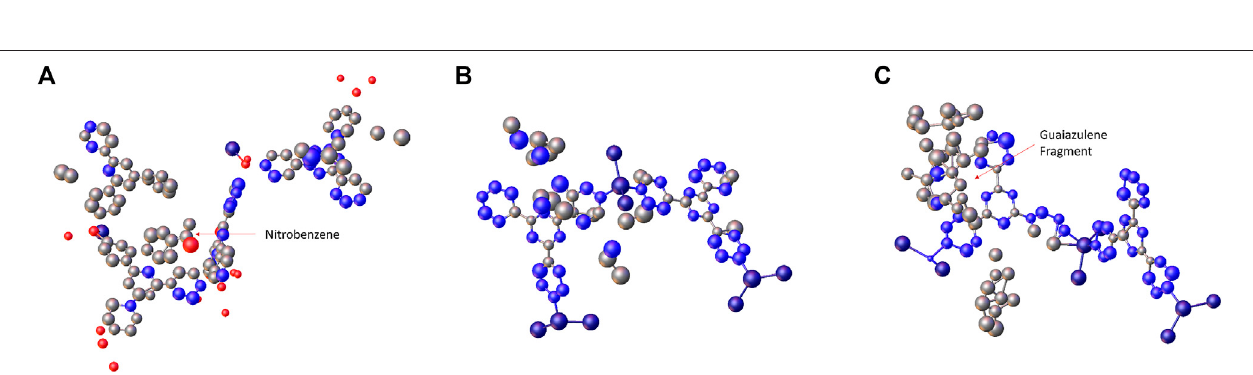
FIGURE 2 | The initial structure model of (A) 1-Nitrobenzene, (B) 1-Cyclohexane, and (C) 1-Guaiazulene obtained from SHELXT.